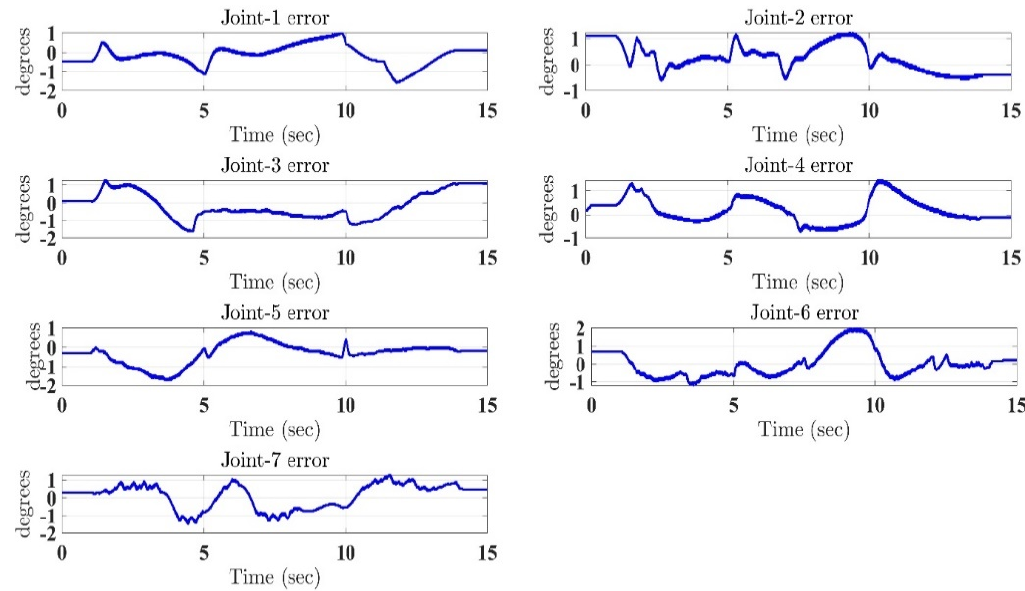
Figure 12. Tracking errors in joint space under the conventional super-twisting controller.